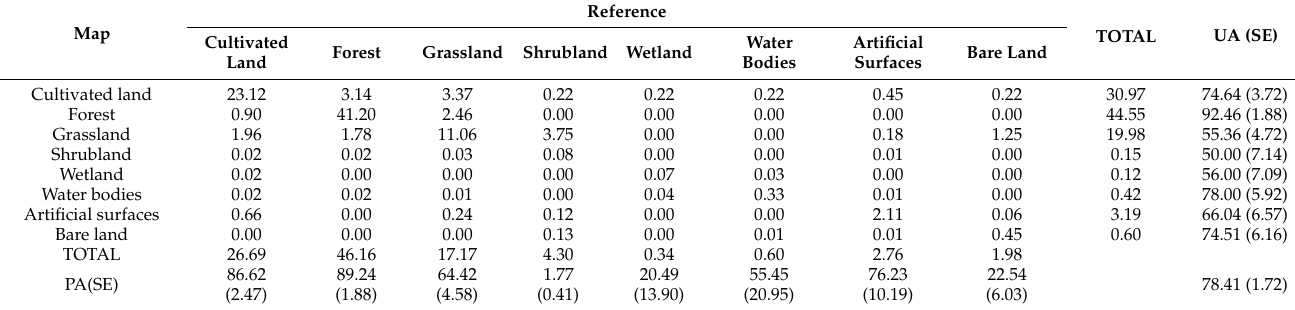
Table A5. Error matrix of GloabLand30 2020.